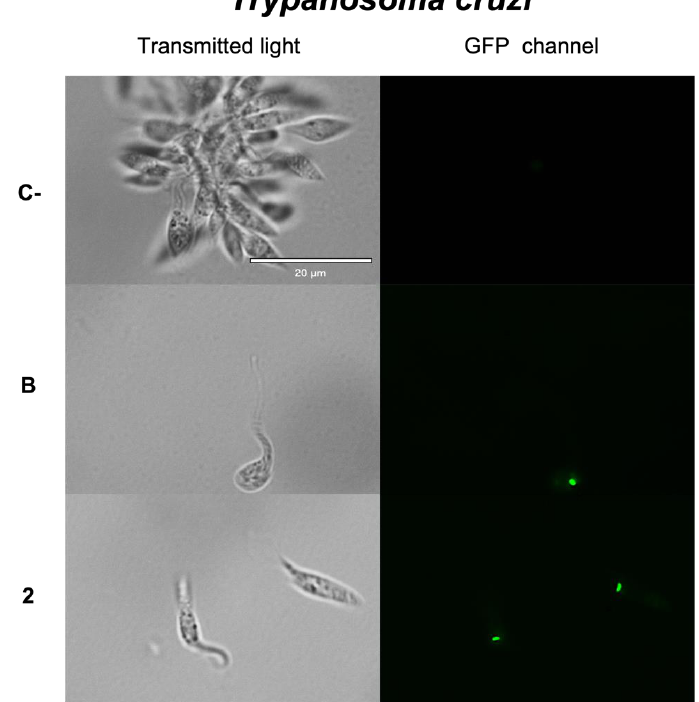
Figure 3. Detection of changes on the plasmatic membrane permeability by SYTOX ® Green staining. The images represent promastigotes of L. amazonensis after 24 h of incubation with the IC 90 of 4β -hydroxyarbusculin A ( 11 ) and anhydroartemorin ( 2 ), promastigotes of L. donovani after 24 h of incubation with the IC 90 of cis,trans -costunolide-14-acetate ( 3 ) and epimastigotes of T. cruzi after 24 h of incubation with the IC 90 of anhydroartemorin ( 2 ). Parasites without any treatment were used as negative control ( C- ), and miltefosine ( M ) and benznidazole ( B ) were used as reference treatments against Leishmania spp. and Trypanosoma cruzi , respectively. Pictures were captured by using an EVOS FL Cell Imaging System (100×). Scale bar: 20 μm.